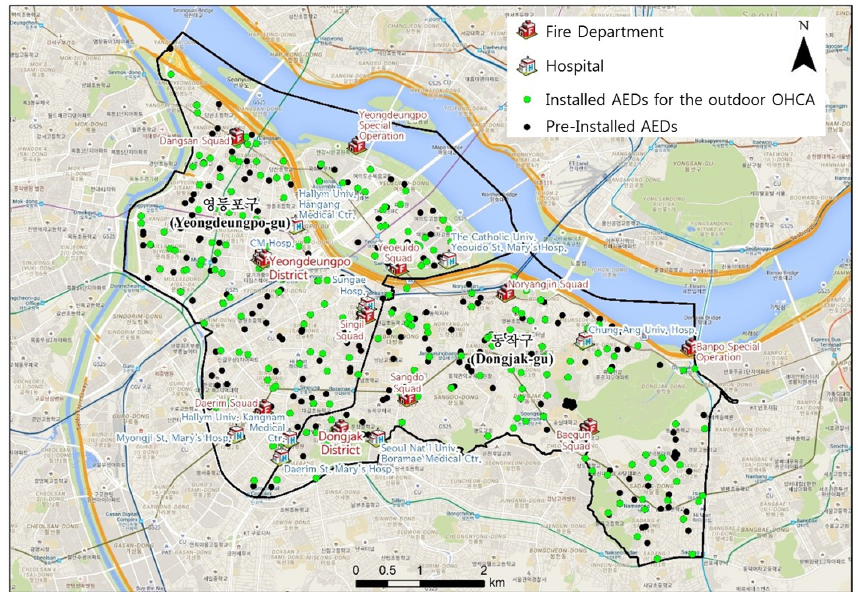
Figure 6. Facilities in the study area.